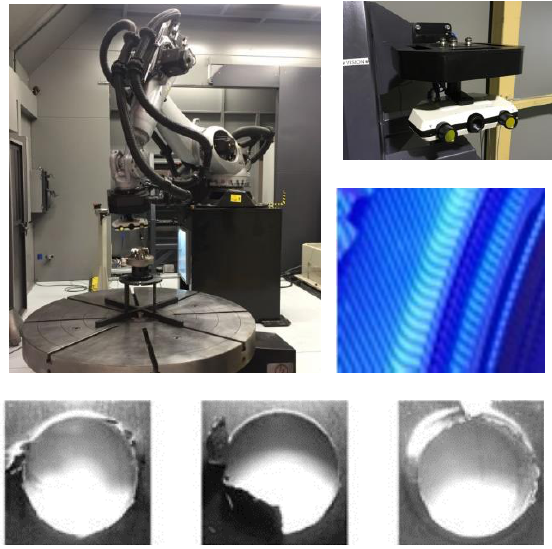
Figure 8. Robotic deburring: robot arm, structured-blue light devices, detail of holes with burrs.